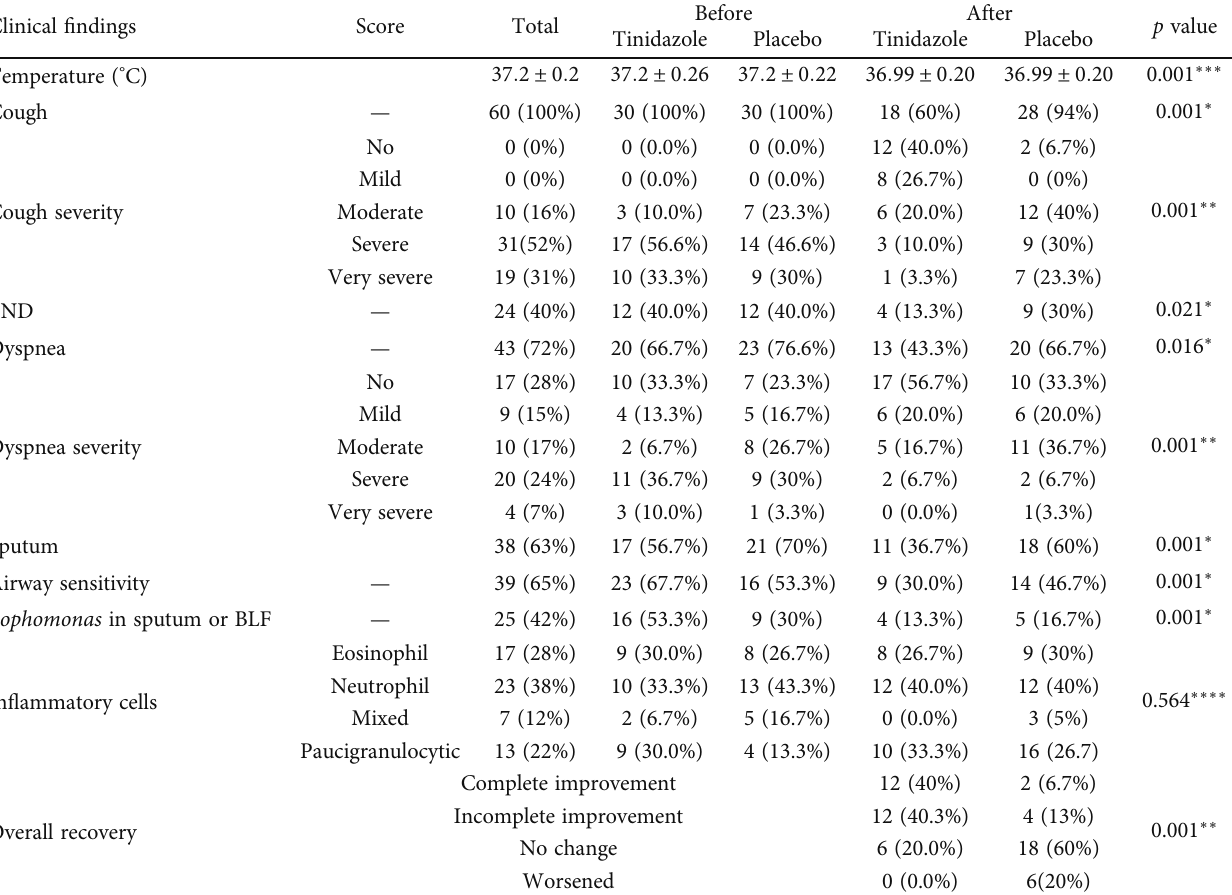
Table 2: E ff ect of tinidazole in course of treatment of Lophomonas Blattarum in subjects su ff ering from persistent cough. Clinical fi ndings Score Total